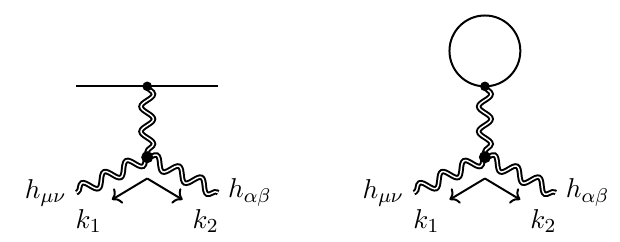
Figure 5. (Left) Example of a Feynman diagram in the set X for the n = 2 current in GR. (Right) The singular diagram produced in the forward